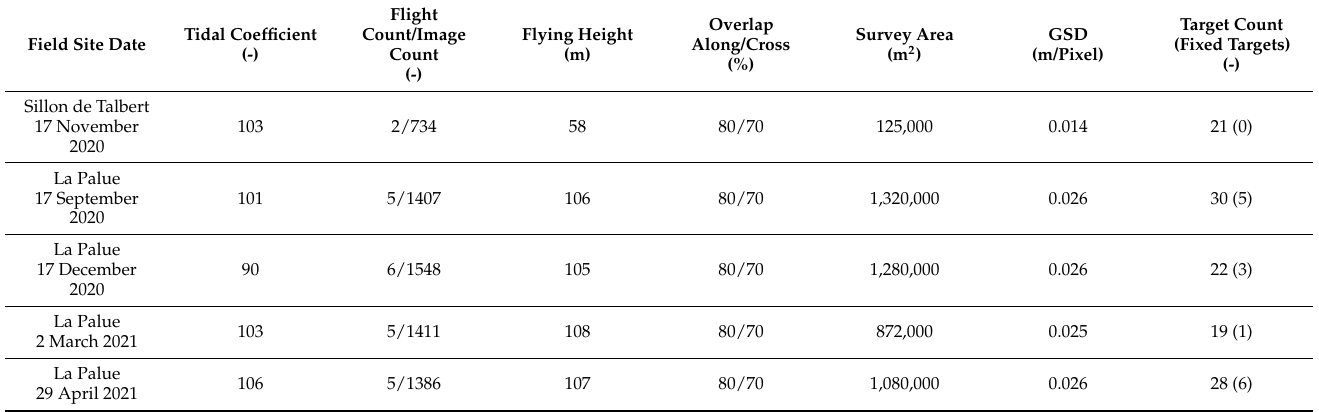
Table 1. Overview of the field surveys and data collection for UAV–SfM photogrammetry. The tidal coefficient (20–120) represents the tide magnitude in relation to its